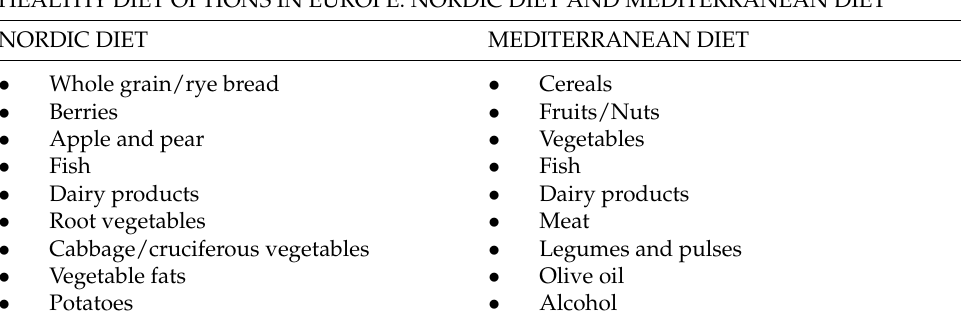
Table 4. Comparison of some aspects of Mediterranean and Nordic diet, derived from Galbete C. [63]. HEALTHY DIET OPTIONS IN EUROPE: NORDIC DIET AND MEDITERRANEAN